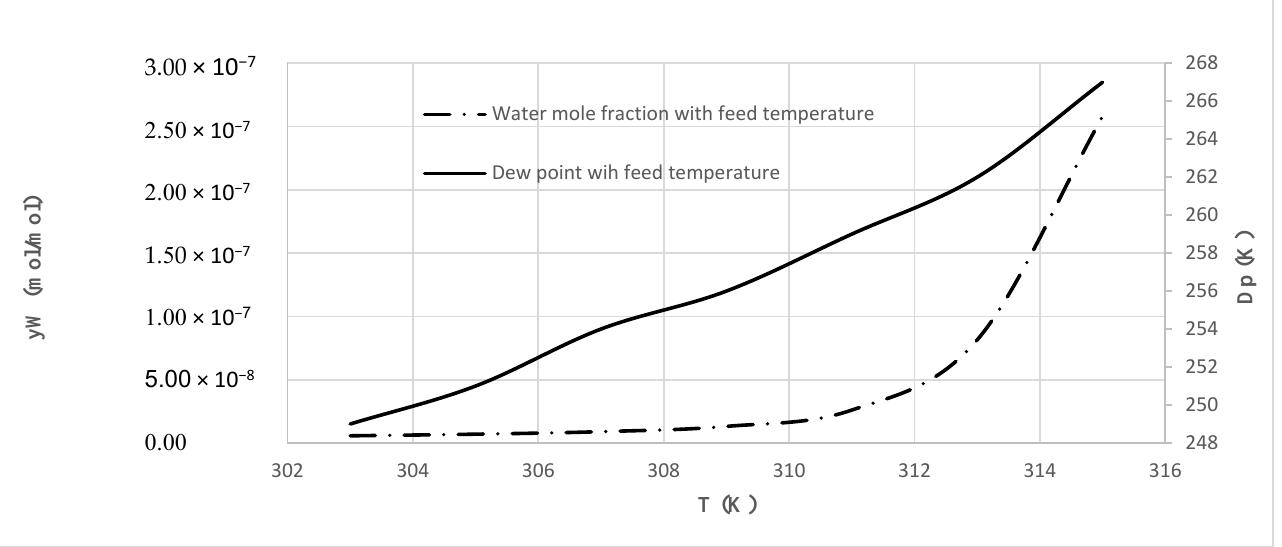
Figure 20. Water mole fraction and hydrocarbon dew point feed temperature in output